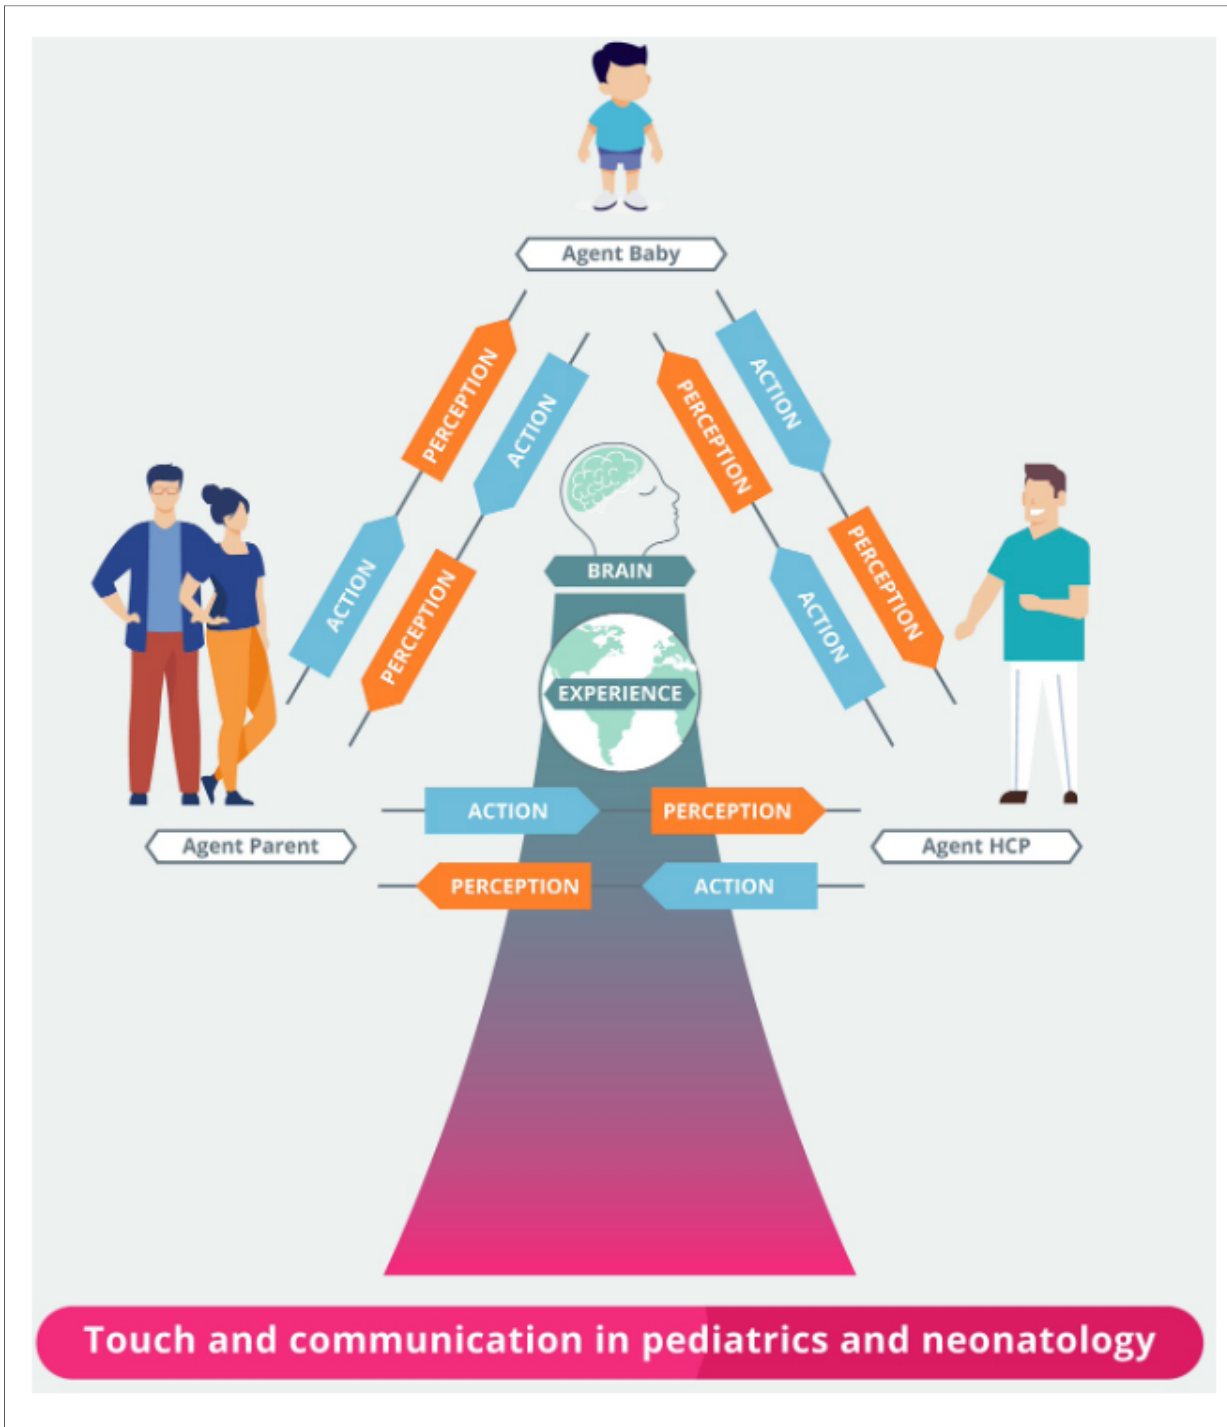
FIGURE 2 Active inference in paediatric care and neonatology. HCP: Health Care